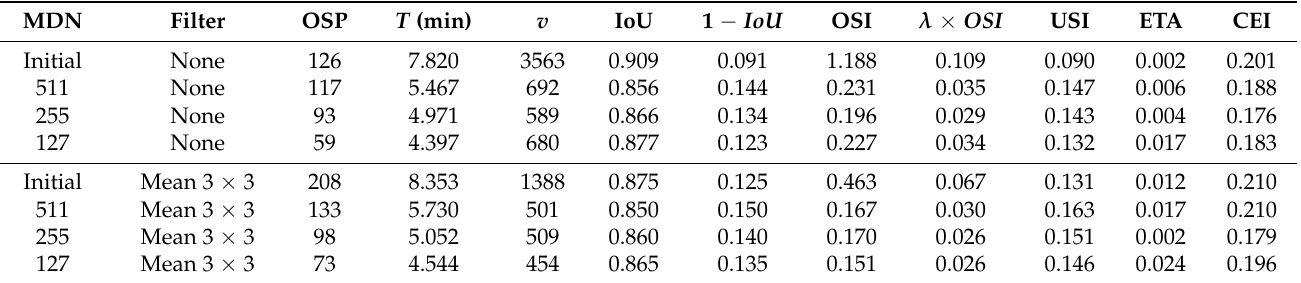
Table 7. Effects of linear compression and mean filtering on segmentation evaluation parameters of